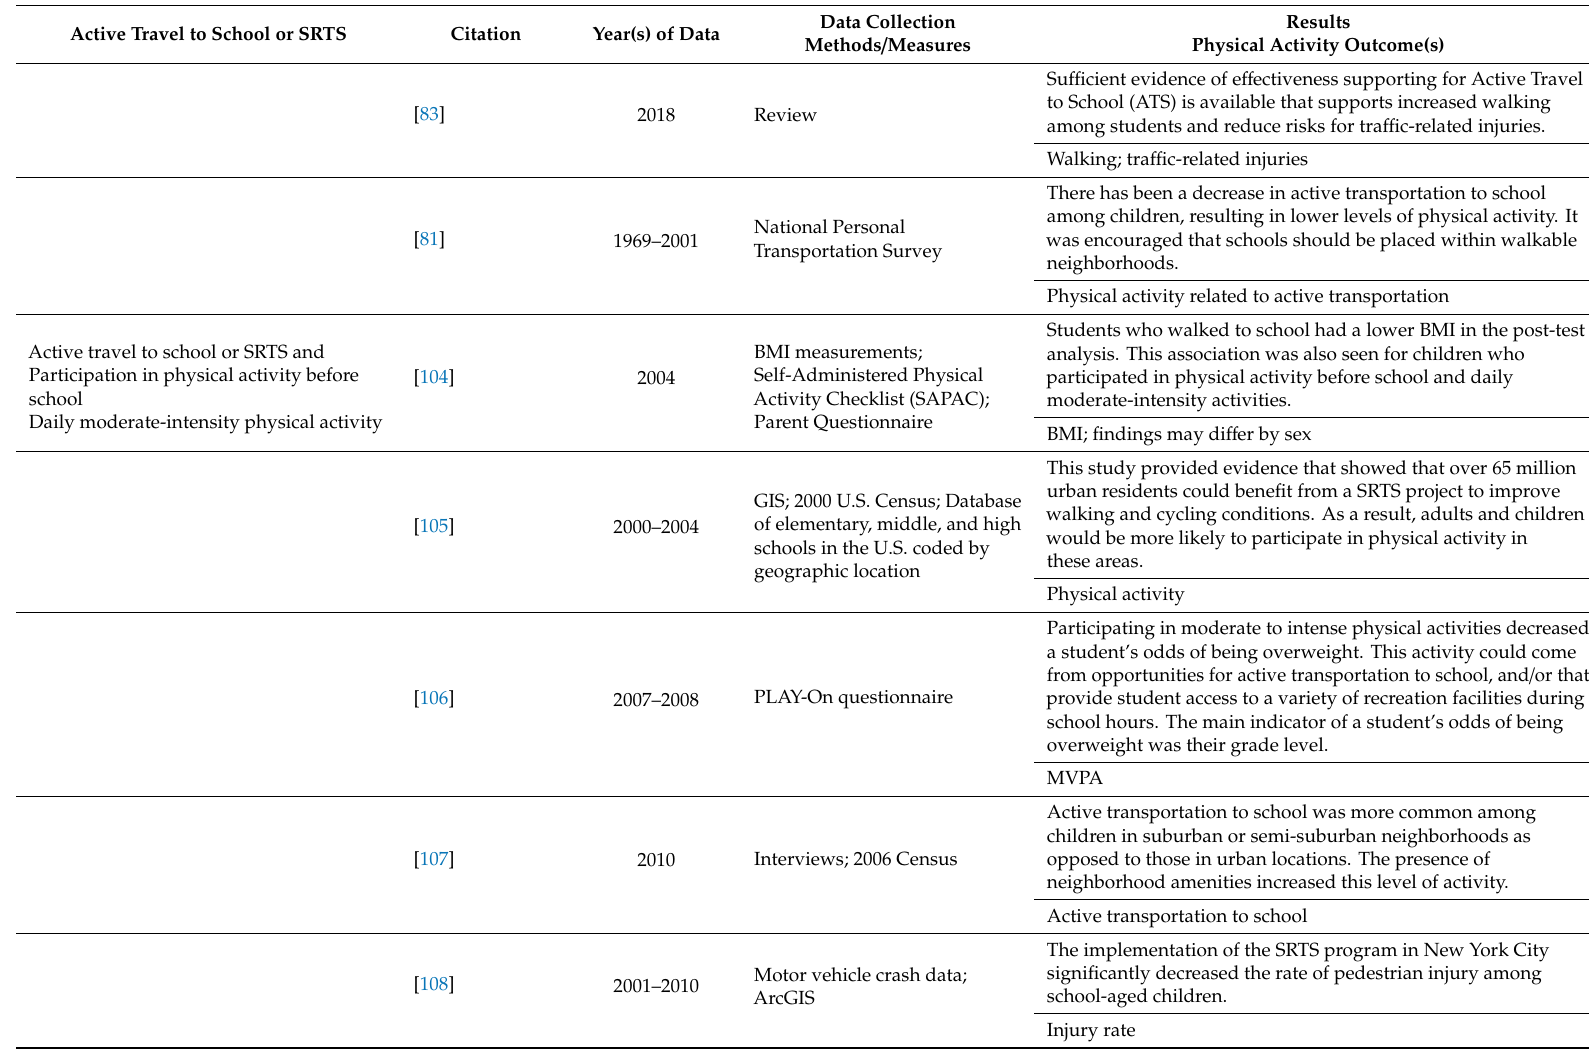
Table A2. Select Studies Evaluating Active Travel to School or Safe Routes to School: An Evidence-based Intervention That May Serve as a Model for Connecting Trails to Youth Trail Use Recreational